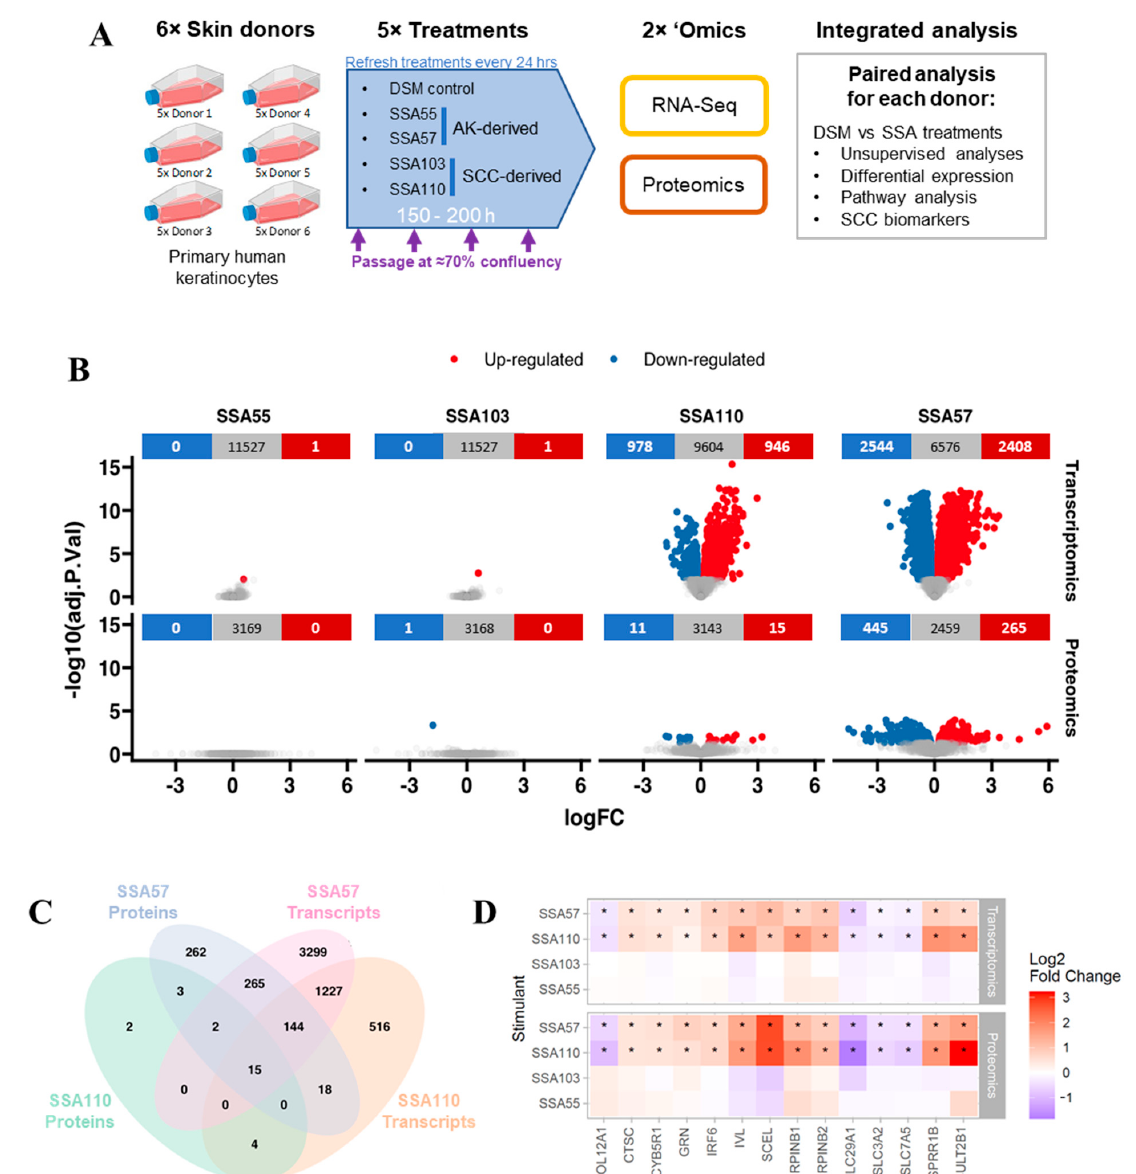
Figure 1. Heterogenous impact of Staphylococcus aureus secretomes on primary human skin keratinocyte transcriptome and proteome. ( A ) Experimental workflow schematic. Primary keratinocytes from six different donors were cultured and treated with secretome from four different S. aureus isolates (designated SSA55, SSA57, SSA103, SSA110), sampled from actinic keratosis (AK) or squamous carcinoma (SCC) lesions as indicated. The bacterial cell culture medium (defined staphylococcal medium, DSM) was used as a negative control for each donor keratinocyte cell line. Treatments were refreshed every 24 h, and cells were passaged at ~70% confluency. After up to 200 h of stimulation, keratinocytes were harvested for RNA sequencing and proteome profiling. ( B ) Volcano plots showing the distribution of log2 fold changes (logFC) and significance (adjusted p -value) in gene expression (top) and protein expression (bottom) in keratinocytes treated with S. aureus secretomes compared to the DSM control (mean of six biological replicates). Using a cutoff of p < 0.01, significantly up- or downregulated genes/proteins are coloured in red or blue, respectively. ( C ) Venn diagram showing the total number of differentially expressed genes/proteins for SSA57 and SSA110 and overlap between conditions. ( D ) Heatmap showing the fold change of the 14 differential genes/proteins consistent across transcriptome and proteome for both SSA57 and SSA110, with data from SSA53 and SSA103 shown for comparison. * p < 0.05.